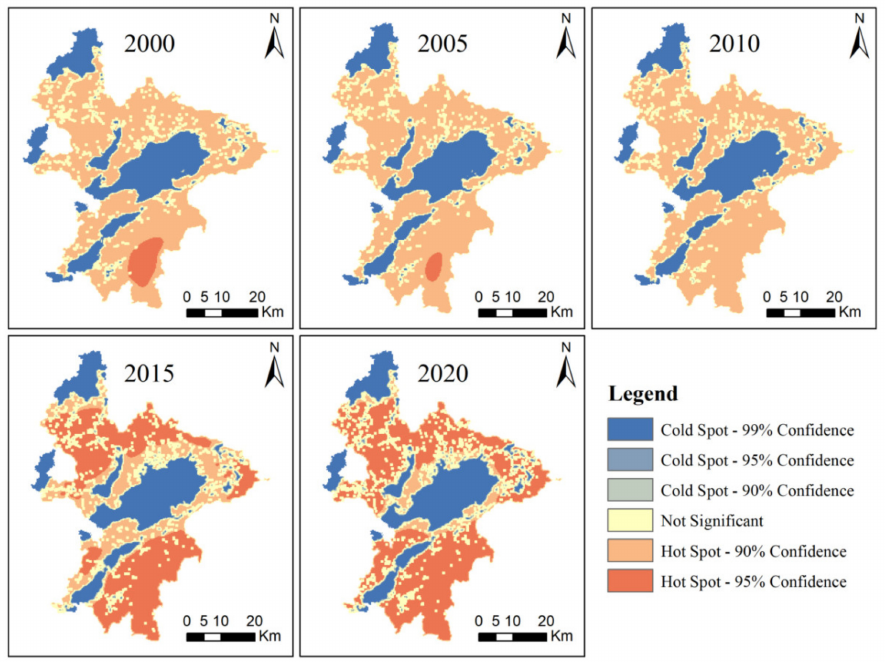
Figure 6. Cluster map of Hot/Cold Spot of ecosystem service values in Ruijin City from 2000 to